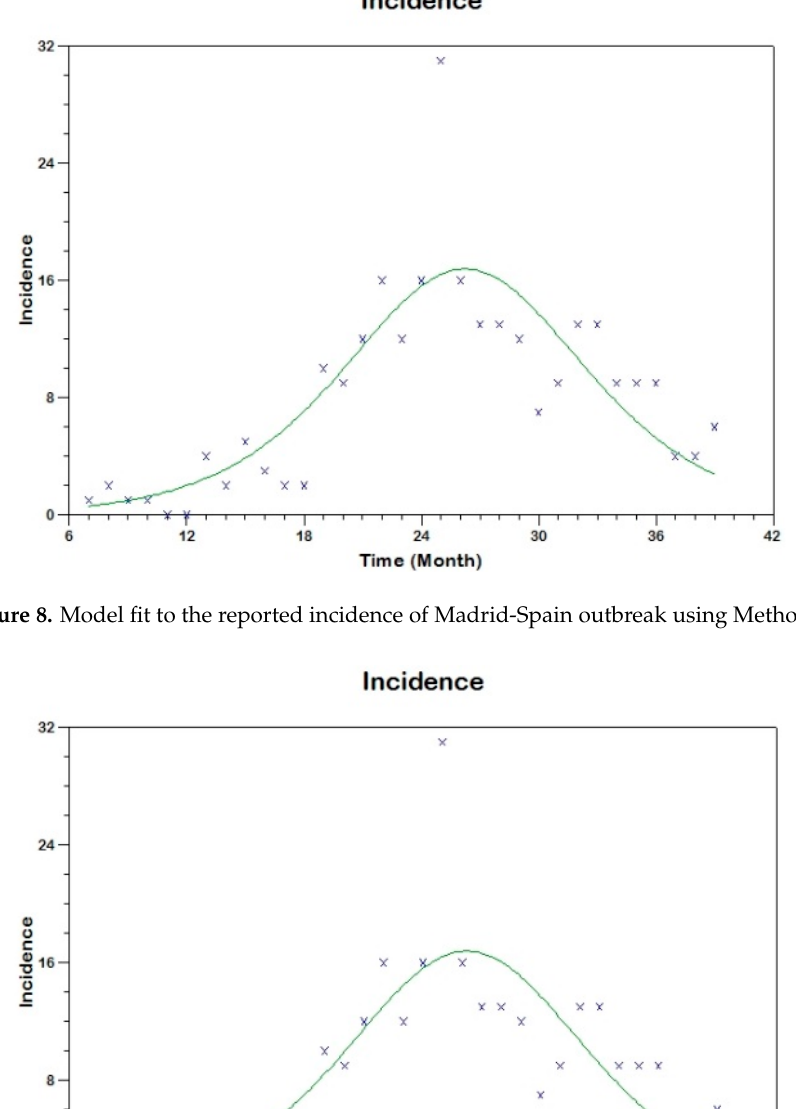
Figure 7. Model fit to the cumulative reported incidence of Madrid-Spain outbreak using Method 0.